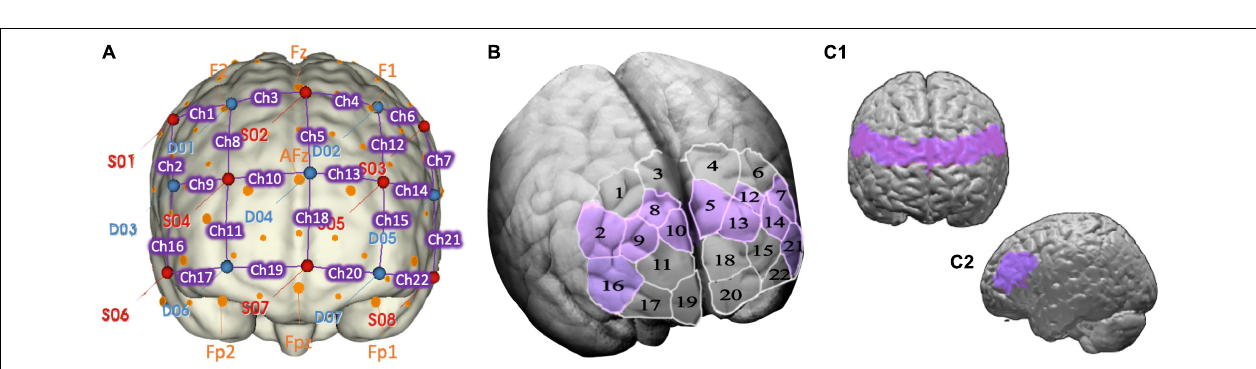
FIGURE 3 | Schematic representation of a trial in the experimental task. The task design is adapted from Kühn et al. (2016). During each trial, one merchandising element was displayed randomly for 3 s. Before and after the merchandising element, the advertised product was shown for 2 s. All stimuli were separated by a randomized jitter of 4–6 s. Figure adapted from Kühn et al. (2016). Permission to reuse had been obtained.